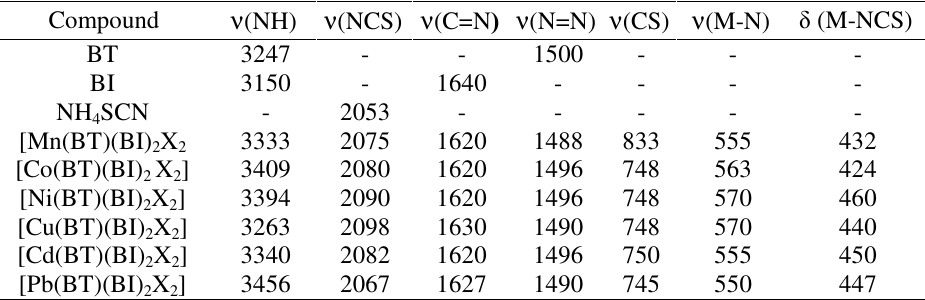
Table 3. Fundamental infrared bands (4000-400 cm -1 ) of the ligands and its complexes Compound